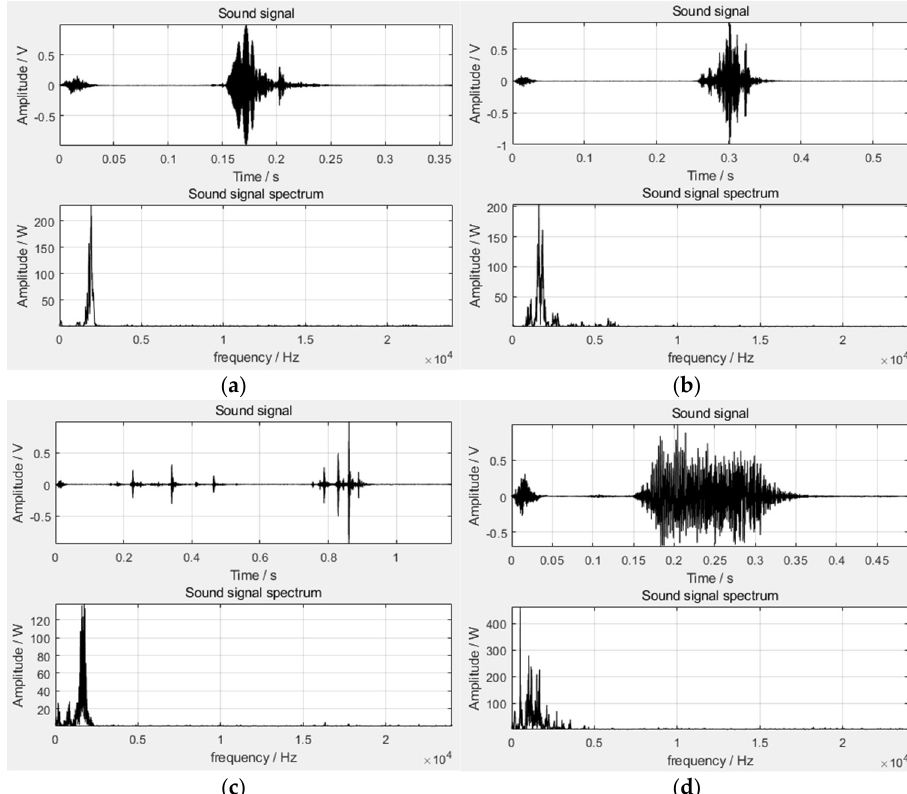
Figure 3. Frequency domain waveform diagram of four sound types. ( a ) Crow; ( b ) Cough; ( c ) Purr; ( d ) Flapping wings.